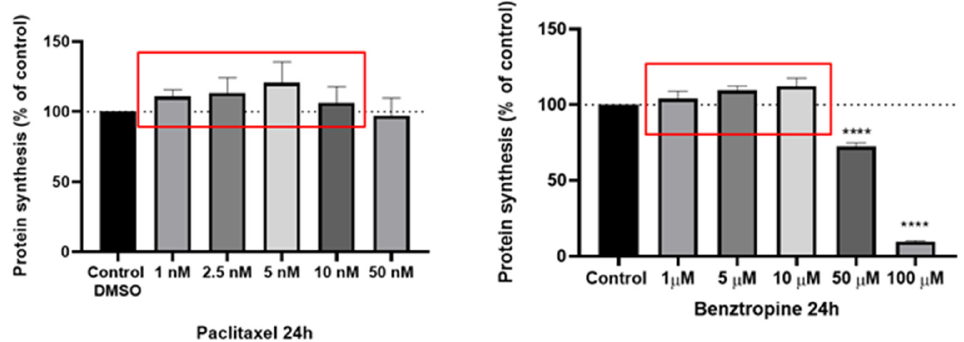
Figure 3. Protein synthesis (% of control) obtained with SRB assay in MCF-7 cells treated for 24 h with paclitaxel (left graph) or benztropine (right graph). The red rectangle marks the increase of protein synthesis at the lowest and middle concentrations. Results are expressed as mean ± standard error of the mean (SEM). **** p < 0.0001.